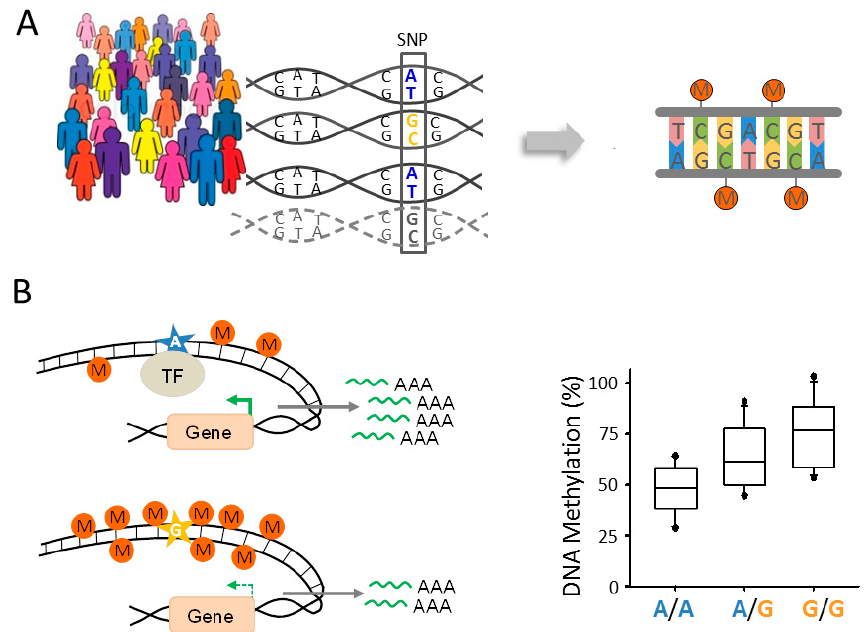
Figure 2. Role of genetic variation for DNA methylation. ( A ) Single nucleotide polymorphisms (SNPs) can control levels of DNA methylation in a population. In this example, the presence of the nucleotide base guanine (G; marked in light orange) is thought to promote DNA methylation at unrelated distant sites (right). The opposite outcome is hypothesized for the nucleotide adenine (A; marked in blue). The dashed line symbolizes further examples, which altogether are used to infer the allele frequency of the respective SNP within the population. In general, genetically induced changes in DNA methylation critically depend on the developmental stage and environmental context to affect gene expression; ( B ) model for cis -meQTLs. A local cis -acting SNP variant (A-allele marked by a blue star) maps to a regulatory element; for example, a transcription factor (TF) binding site. Sequence variation (G-allele marked by a light orange star) can lead to a reduced binding of the TF, decreased gene transcription (symbolized by green arrows of different strength when comparing the A- to the B-allele), and encroachment of DNA methylation (M), symbolized by filled dark orange circles. As shown by the chart, cis -meQTLs can lead to differences in the amount of CpG-methylation between two copies of an allele. Homozygous carriers of the transcriptional active A-allele show less DNA methylation when compared to homozygous carries of the transcriptional less active G-allele or heterozygous carriers (right).